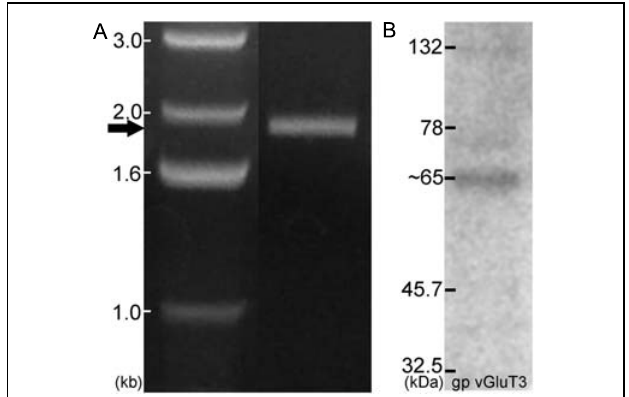
FIGURE 4 | Co-localization of TH and DBH in the IC reveals three types of labeling. In the external cortex of the inferior colliculus (ECIC) labeling for TH (red) and TH + DBH (yellow) is observed throughout the nucleus (A) . The majority of fibers and terminals in the deeper layers of the ECIC were co-localized for DBH and TH (e.g., arrows) and occasional labeling for fibers containing only TH were observed (A’–A”’) . In the more superficial layers of the